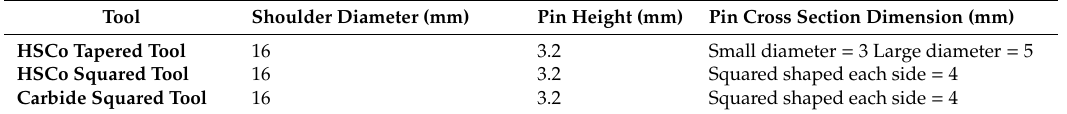
Table 2. Specifications of FSW tools.